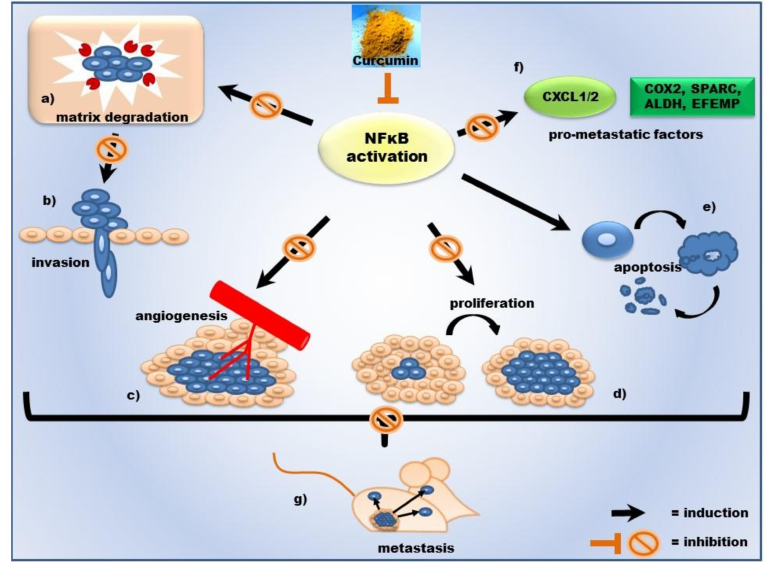
Figure 2. Schematic illustration of the effects of curcumin on prostate cancer. Curcumin has various effects on the development and progression of cancer via inhibition of NF κ B signaling, followed by a downregulation of its target genes. Curcumin reduces tumor cell proliferation, induces apoptosis ( d , e ), and inhibits angiogenesis ( c ). Additionally, Curcumin inhibits gene expression of matrix-degrading proteases (matrix metalloproteases) and thereby invasion of tumor cells ( a , b ). Furthermore, the expression of metastasis-associated genes is reduced ( f ). As a summation of the single effects, the inhibition of lung metastasis in an animal model (murine mouse model) can be considered ( g